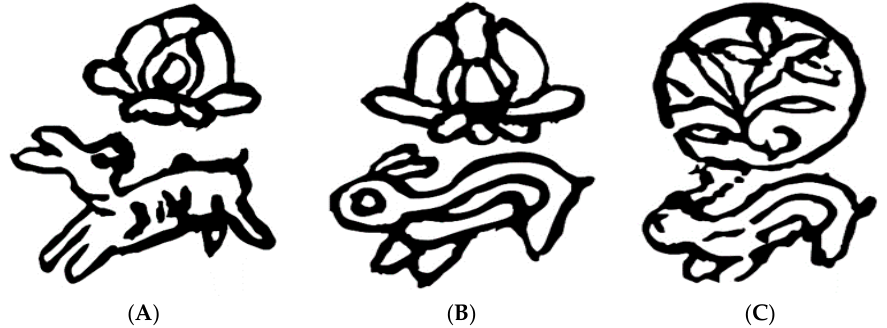
Figure 10. ( A ) A Song Yuan Huaya with a Hare motif and a “Shoutao 壽桃 (the Longevity Peach)” lotus. The period of the Song and Yuan Dynasties. Inventory number: 0694. Sketched by author. Picture source: Wen (1995), p. 199. ( B ) A Song Yuan Huaya with a Hare motif and a stylistic lotus. The period of the Song and Yuan Dynasties. Inventory number: 0693. Sketched by author. Picture source: Wen (1995), p. 199. ( C ) A Song Yuan Huaya with a Hare motif and a floral motif. The period of the Song and Yuan Dynasties. Inventory number: 0704. Sketched by author. Picture source: Wen (1995), p. 201. The original collection: Zhuang, Sun. Xue Yuan Cang Yin [ 《 雪 園 藏 印 》 ]. Book of impressions.